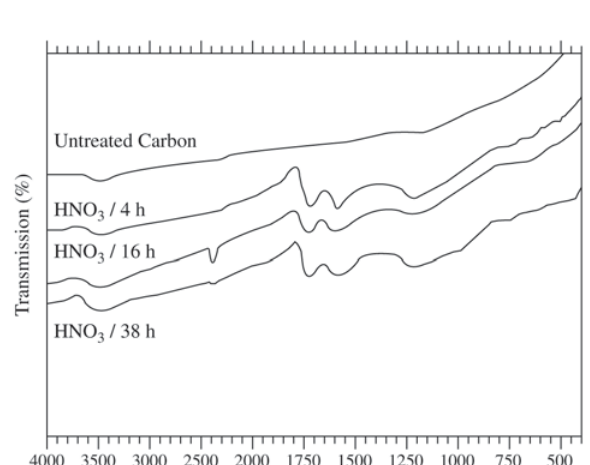
Figure 2. IR spectra of the HNO